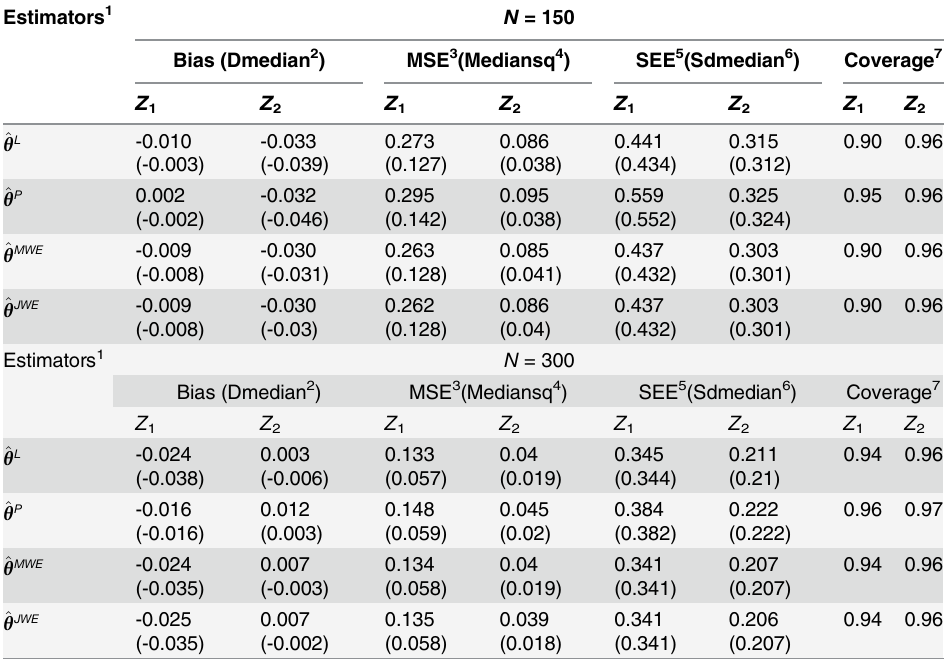
Table 4. Simulation result when N = 150 and N = 300, σ 2 = 1 with two covariates (Z 1 : U(0,1), Z 2 : Ber- noulli(0.5)).